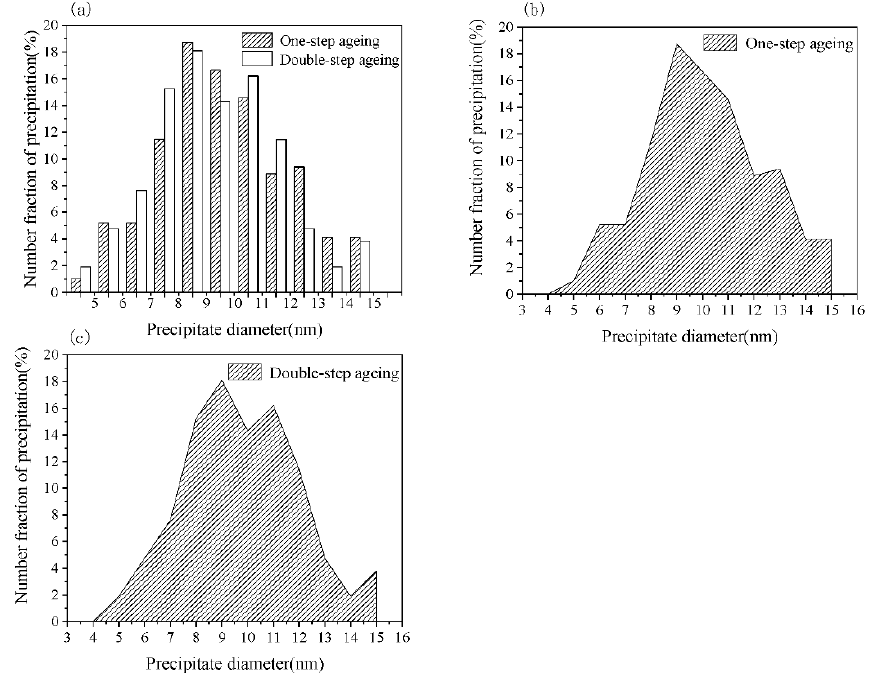
Figure 7. Precipitate size distributions: ( a ) histogram (the uncertainty is 1 nm) and the shadow region diagram of ( b ) one-step aging for 16 h at 140 °C and ( c ) DA treatment (3 h at 120 °C and 3 h at 160 °C).